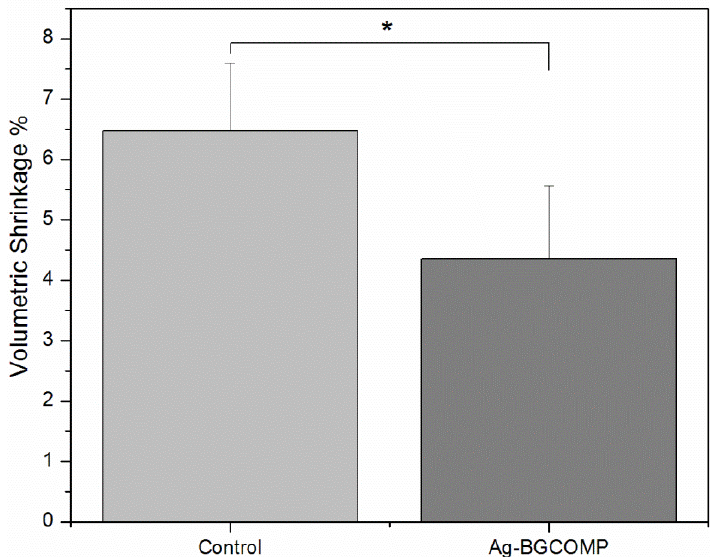
Figure 3. Volumetric polymerization shrinkage % mean value for control and Ag-BGCOMP. * = statistically significant difference ( p = 0.0002) between the two groups. Error bars represent the standard deviation (SD) calculated in each